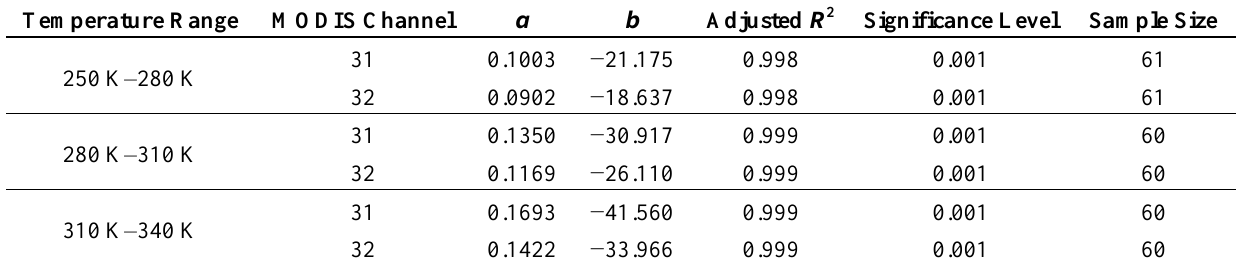
Table 2. Coefficients for linearizing Planck’s functions of MODIS channels 31 and 32 in different temperature ranges. The parameters for regression analysis are also